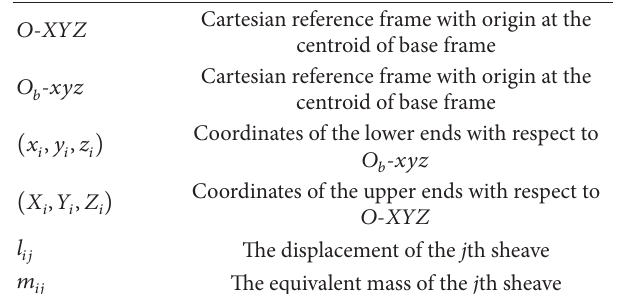
Table 1: Meaning of symbols in Figure 2.